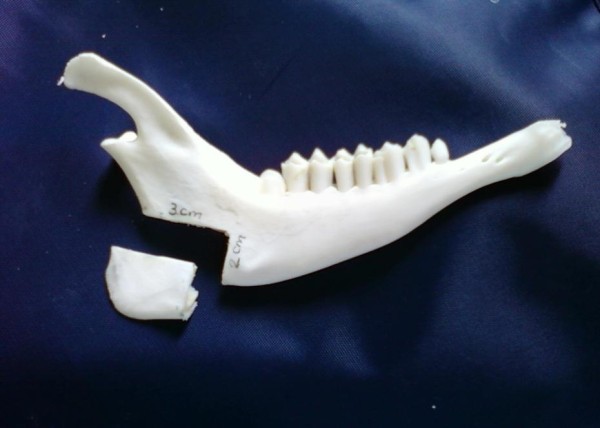
The defect created.